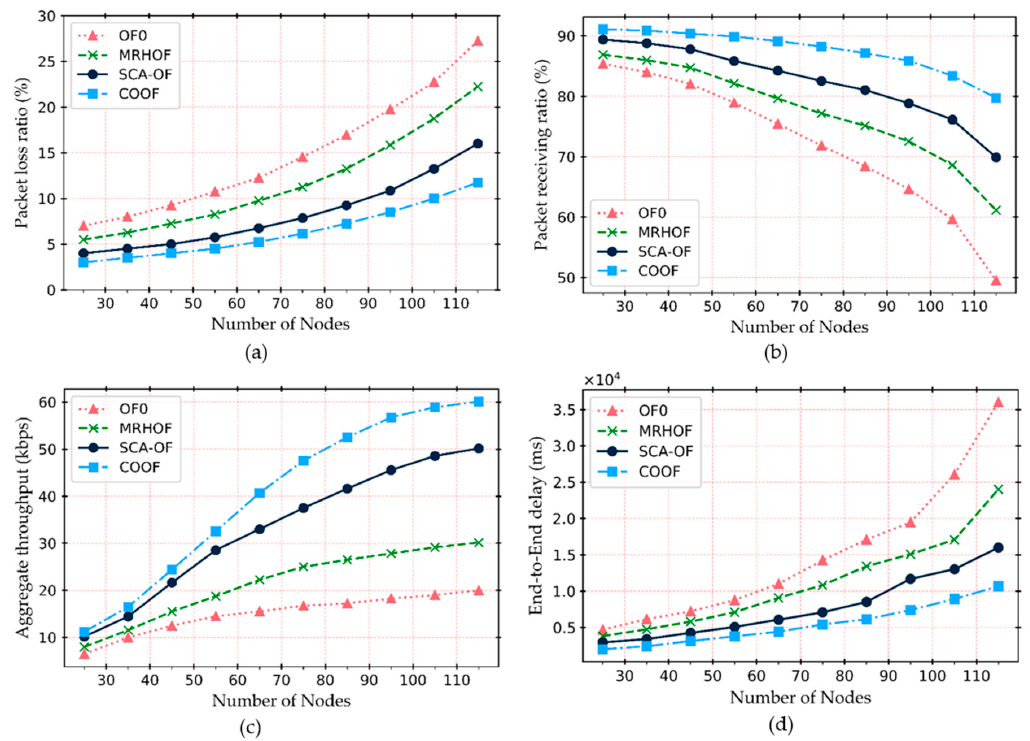
Figure 14. The impact of the network size variation on different performance metrics; ( a ) packet loss ratio, ( b ) packet receiving ratio, ( c ) aggregate throughput, and ( d ) end-to-end delay in milliseconds.